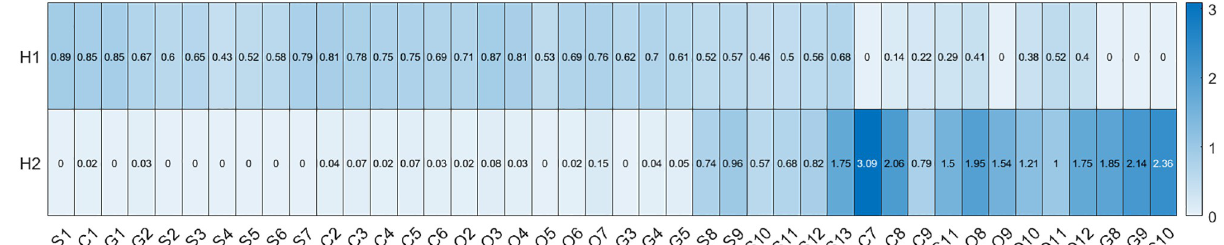
Fig 13. Heatmap of the coefficients in sparse NMF. Sparse NMF forces the coefficients of the objectives to take on the form of basis vectors, as well as sorts them into quantity (H1) and proportional (H2) objectives.